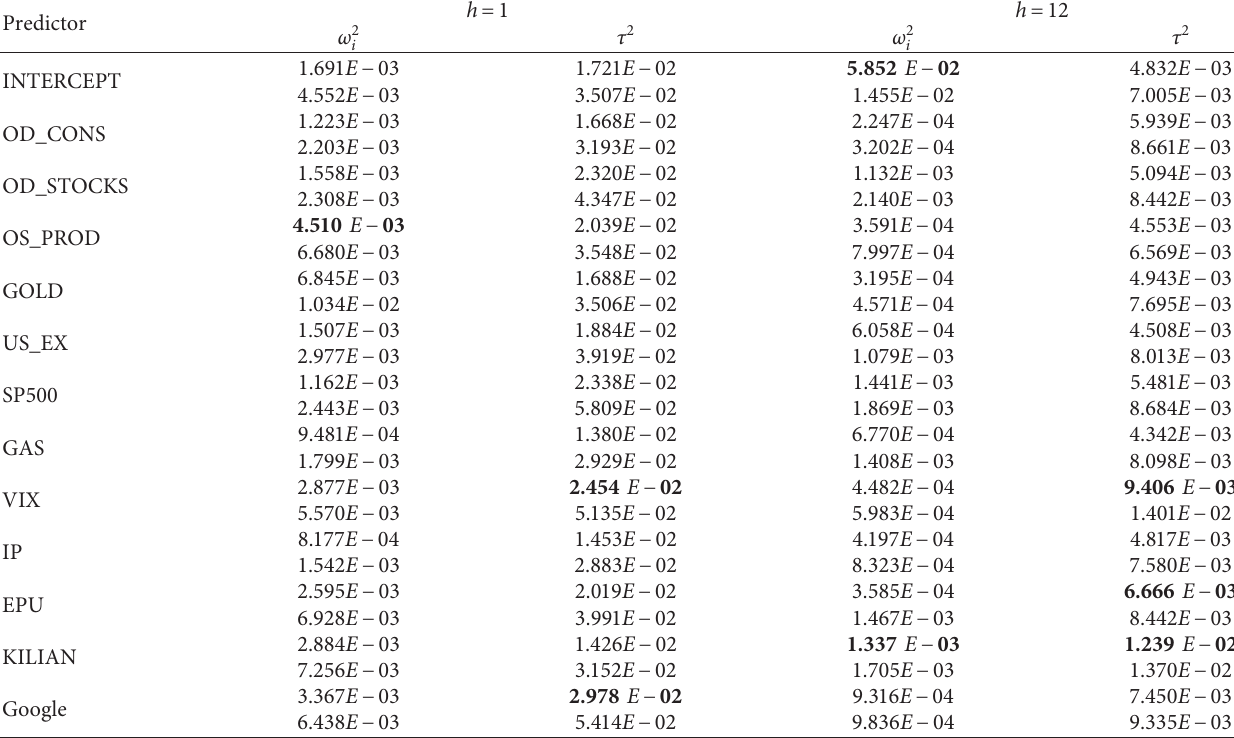
2 for exogenous i and τ